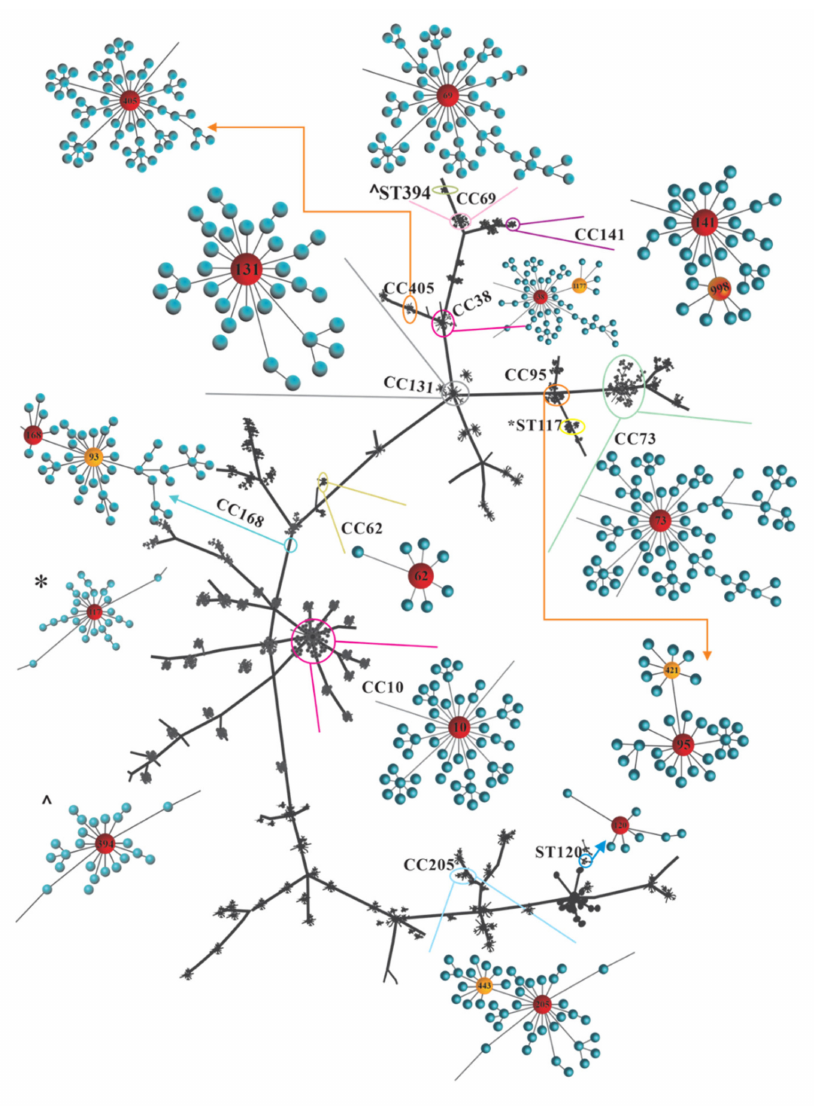
Figure 3. eBURST analysis of UPEC O25b clinical strains. eBURST analysis was performed based on single-locus variants (SLVs). Red shows the founding STs of a clonal complex (CC), and orange shows the STs that differ in only one gene sequence from the founding